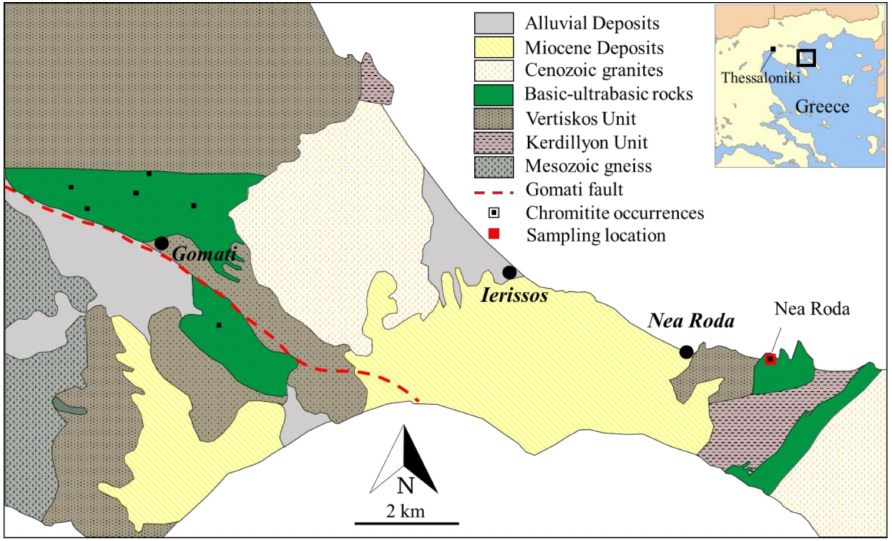
Figure 2. Modified excerpt of the 1:50,000 scale geological map of the Ierissos sheet [30]. The red square indicates the sampling location.